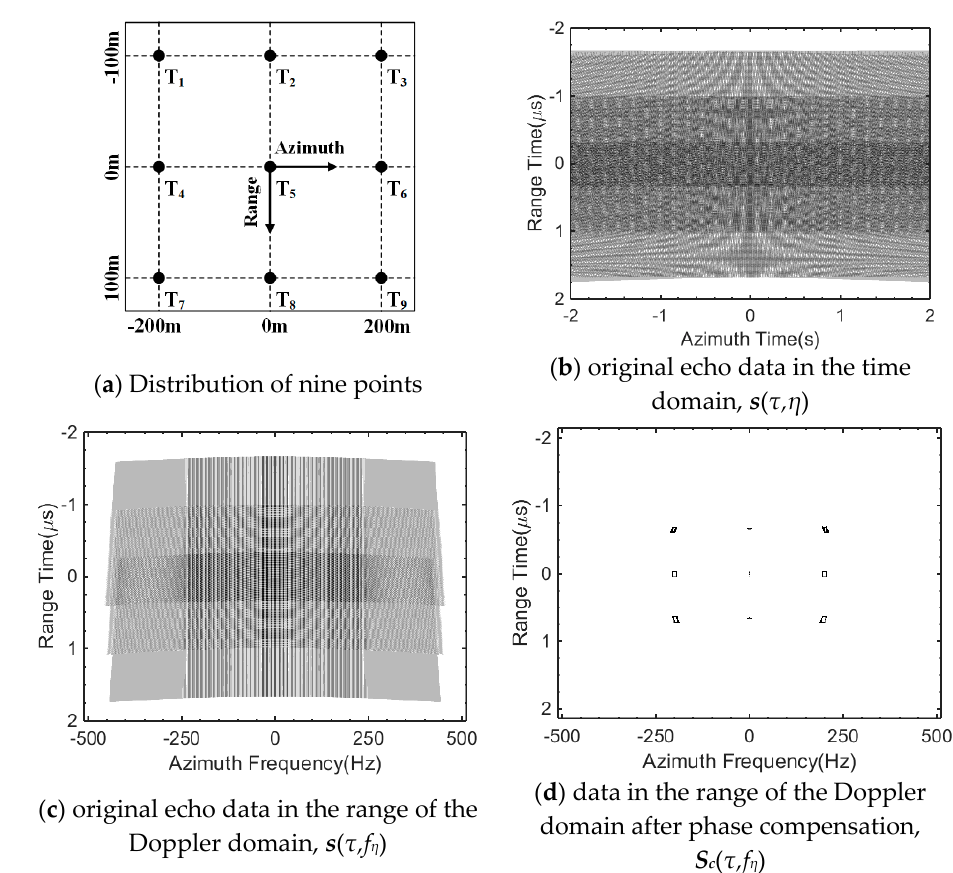
Figure 3. Coarse compression of point targets: ( a ) distribution of nine points; ( b ) original echo data in the time domain, s ( τ , η ); ( c ) original echo data in the range of the Doppler domain, s ( τ ,f η ); and ( d ) data in the range of the Doppler domain after phase compensation, S c ( τ ,f η ).